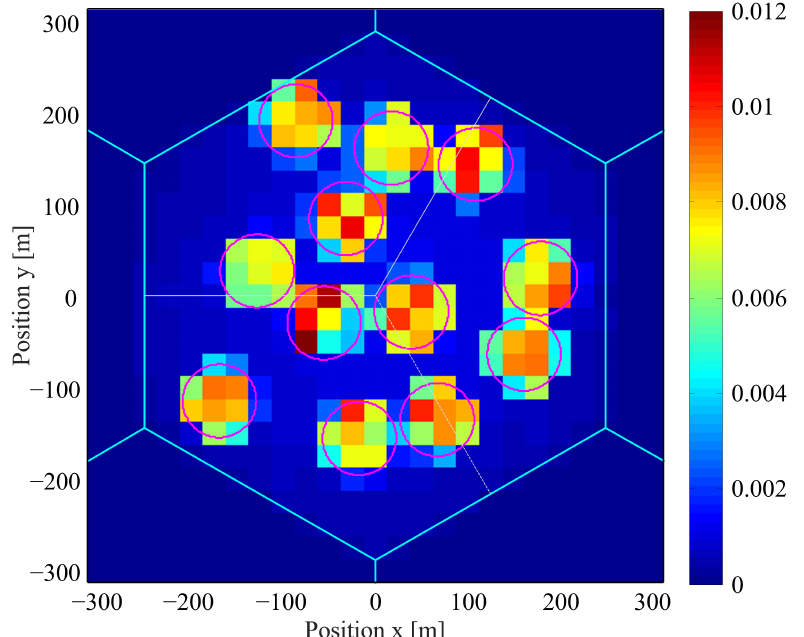
Figure 3. The spatial distribution of users.